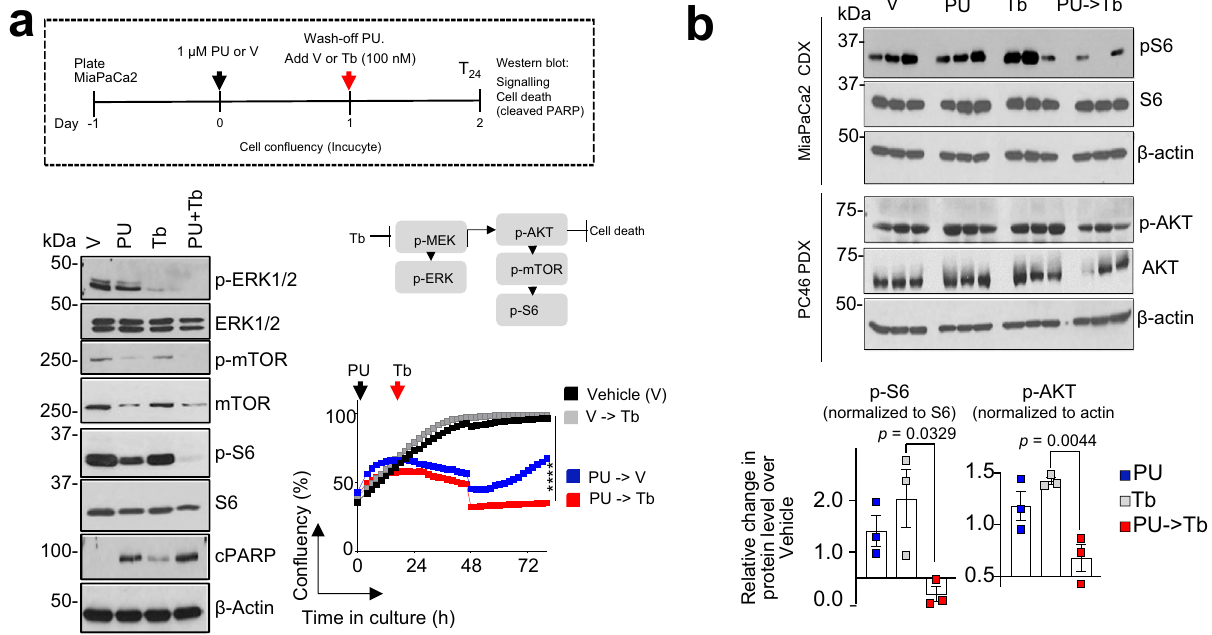
Fig. 9 Feed-back mechanisms are suppressed in cells forced into a state of interactome hyperconnectivity. a Schematic of the experimental design and Western blot analysis of signalling activity and cell death, as indicated. Representative data from three independent experiments are shown for Western blots. For cell con fl uency monitored by microscopy, each curve represents the mean of three biological replicates treated with the indicated agents alone or in the sequential application; two-way ANOVA, V- > Tb versus PU- > Tb, **** p < 0.0001. b Signalling activity in individual tumours ( n = 3 from each cohort as in Fig. 8). Error bars mean ± SEM; unpaired two-tailed t